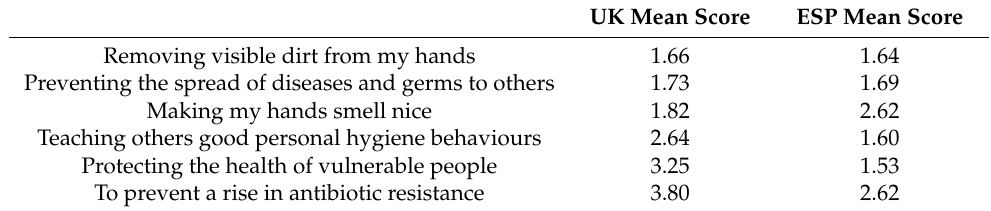
Table 6. In your opinion, how effective is adequate hand hygiene practice in relation to the